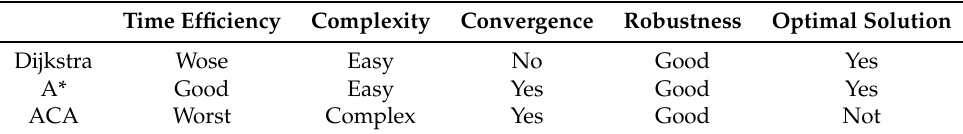
Table 1. Comparison of the three